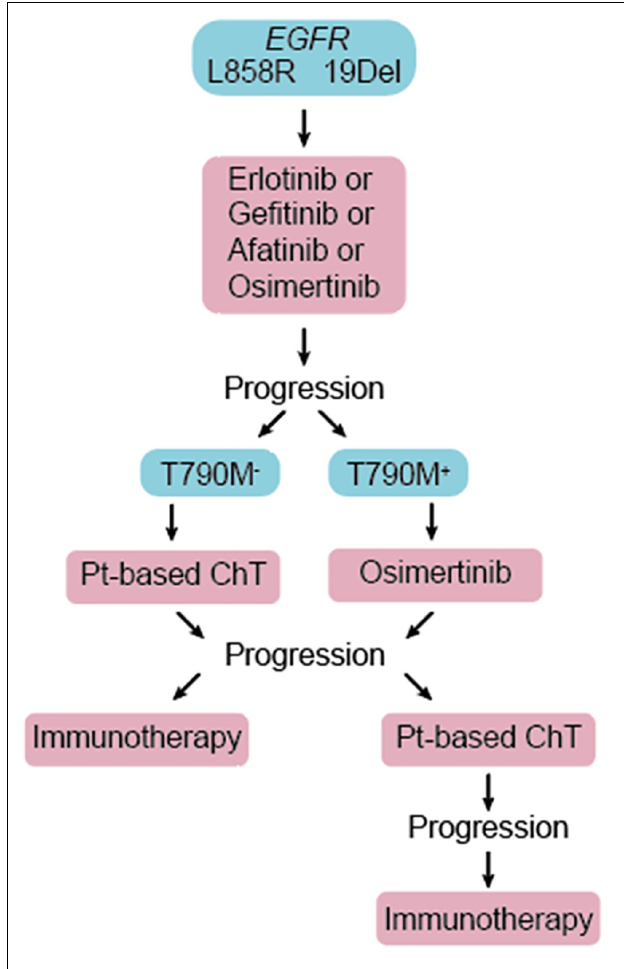
FIGURE 1 | Patients diagnosed with advanced EGFR -mutant NSCLC are treated with one of the approved EGFR TKIs in the first line. Upon disease progression, repeat molecular testing is recommended. Patients not previously treated with osimertinib and whose tumor acquired second site T790M mutation in the EGFR gene (T790M + ) are treated with 3rd generation EGFR TKI, osimertinib. Platinum-based chemotherapy (Pt-based ChT) and immunotherapies are reserved for T790M − patients, and those who progress on